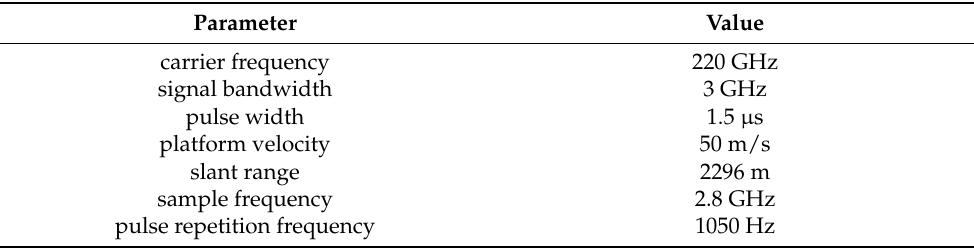
Table 1. System parameters.